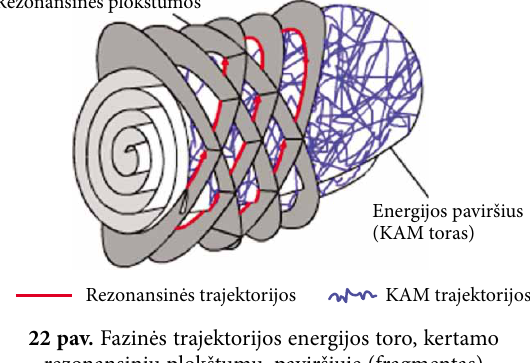
22 pav. Fazinės trajektorijos energijos toro, kertamo rezonansinių plokštumų, paviršiuje (fragmentas) Fig. 22. Phase trajectories on the surface of energy torus crossed by resonant planes (fragment)